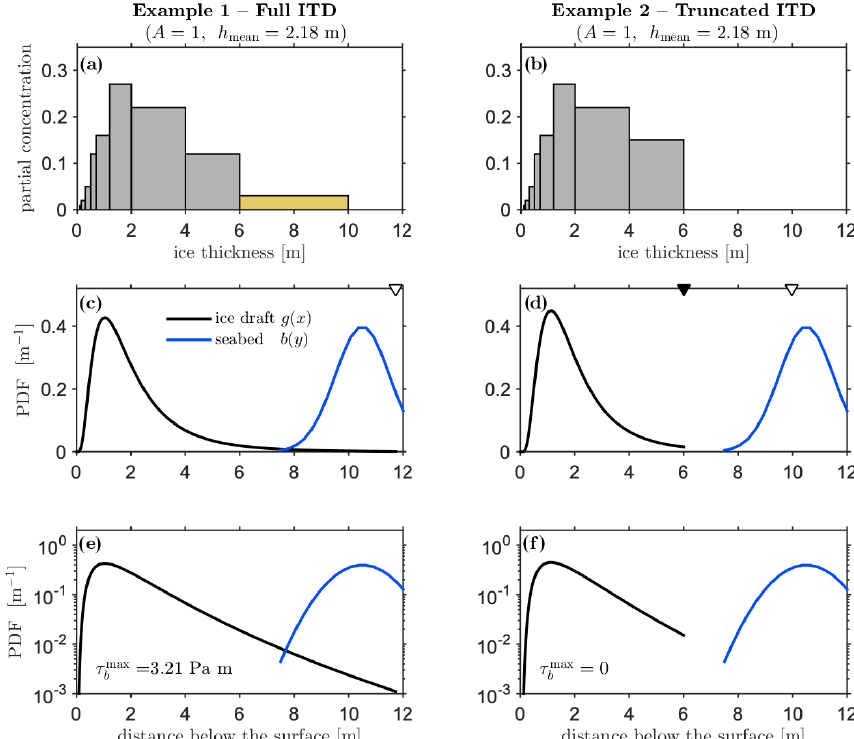
Figure 1. Examples showing how the maximum seabed stress due to seabed–ice friction is calculated. Panels (a, c, e) show an example where all ice thickness categories are populated, including the last one (yellow bin) – note that for visualization purposes the last category is bounded arbitrarily at 10m. The corresponding thickest keel draft is the 99.7th percentile of the thickness PDF (black line), which is x 997 = 11 . 73m (open triangle). Panels (b, d, f) show an example where the partial concentration of the thickest ice category is zero. The corresponding thickest keel draft is the maximum thickness of the last category (black triangle, x = 6m), even though x 997 = 9 . 96m (open triangle). The maximum basal stress τ max is here computed with a Gaussian bathymetric PDF with µ b = 10 . 5m and σ b = 1 . 0m 2 and truncated at 3 σ b on b both sides of the distribution (blue line). The PDFs are shown in linear (e, f) and logarithmic scales (c, d)